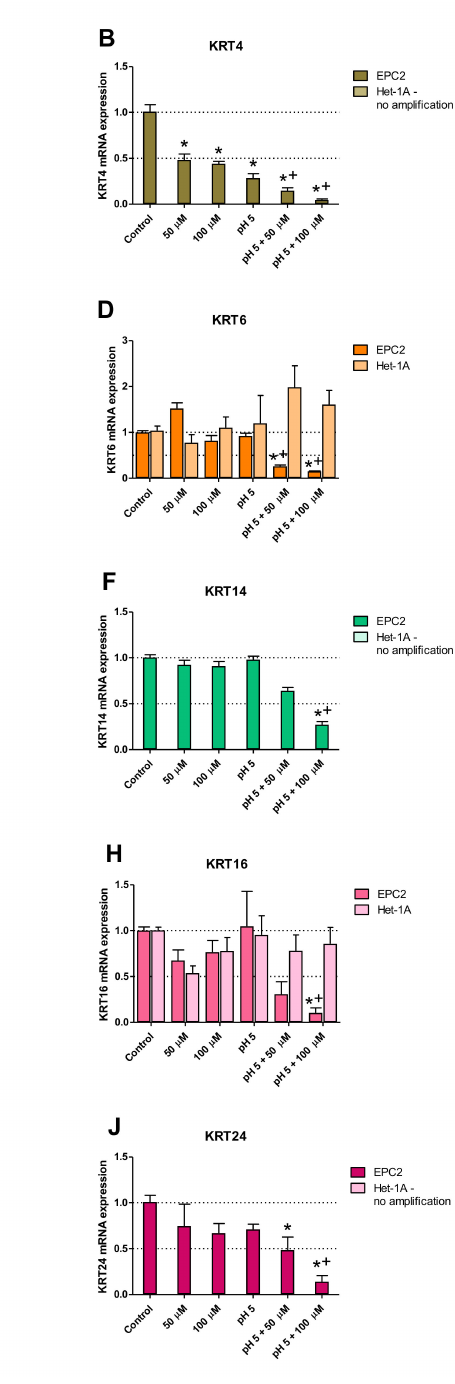
Figure 4. Squamous epithelium-specific mRNA expression upon incubation of Het-1A and EPC2 cells with bile mixture (BM) at pH 5.0. Het-1A and EPC2 cell lines were incubated with BM (50 µ M and 100 µ M) in acidified medium (pH 5.0) or regular medium for six consecutive days and squamous epithelium-specific mRNA expression was analyzed by real-time PCR ( A – J ). PCR reaction was performed in duplicates and quantified using ACTB / GAPDH as reference genes. Data from three independent experiments are shown as the mean ± SEM. Significant change in gene expression after six days of treatment as compared with untreated control cells is indicated by an asterisk (*) ( p < 0.05). A cross ( + ) indicates a significant change as compared with cells incubated with pH 5.0 alone ( p <